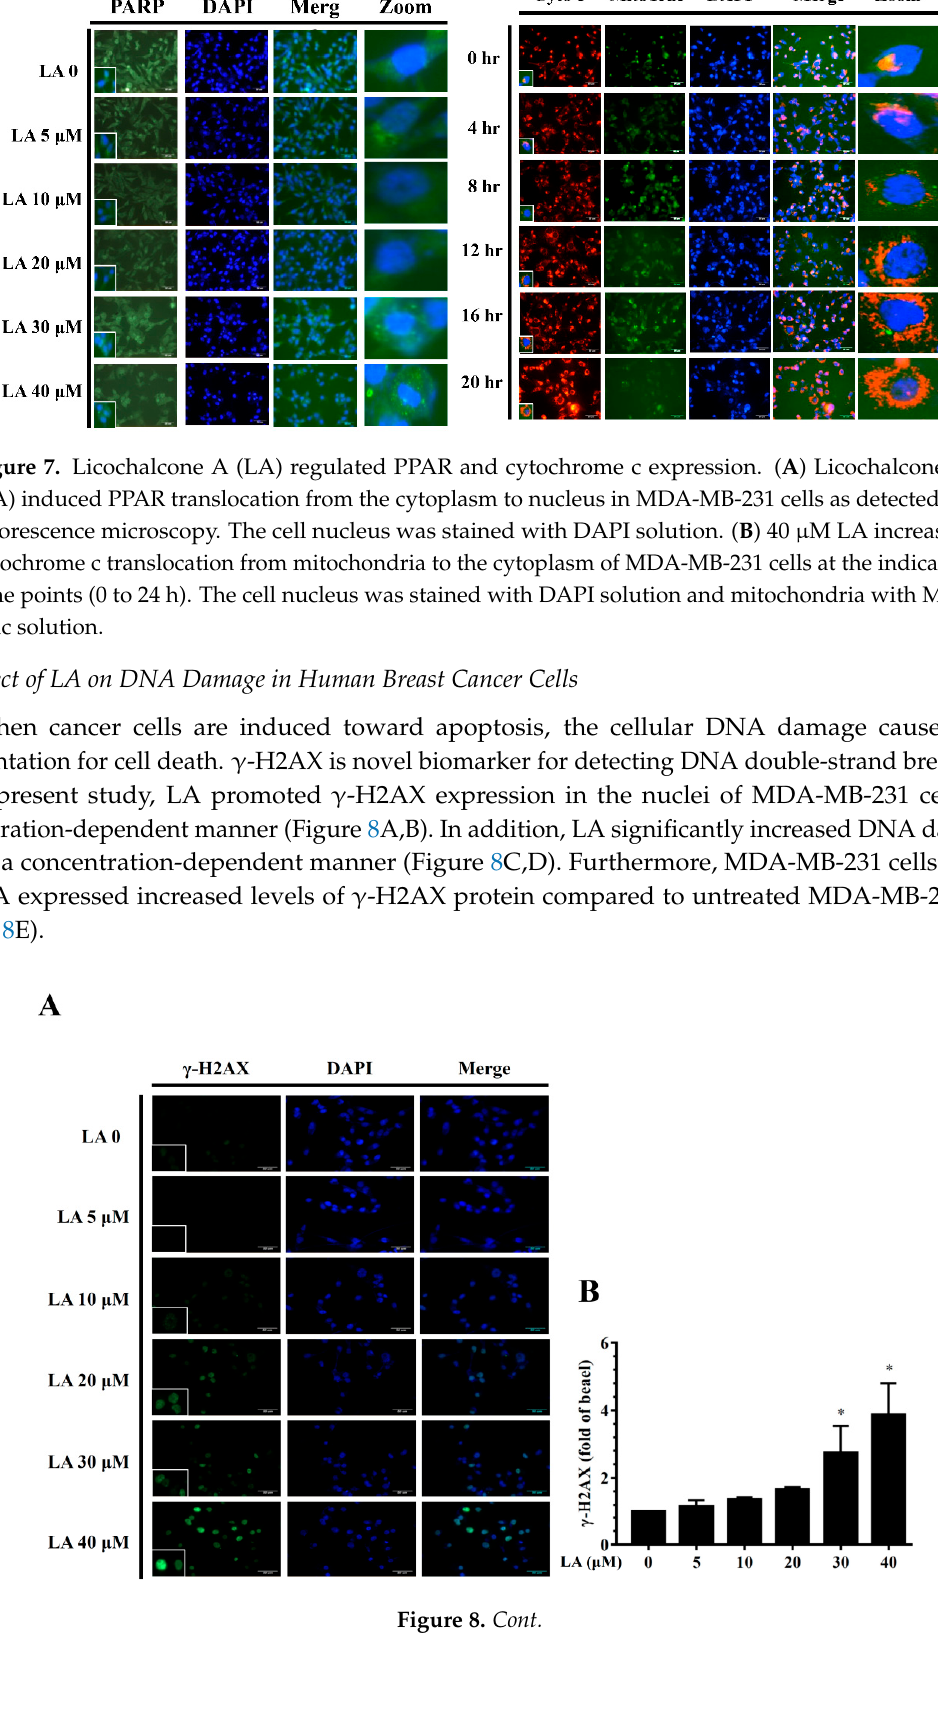
Figure 8. Effect of licochalcone A (LA) on DNA damage in MDA-MB-231 cells. ( A ) Cells were seeded on a culture plate and treated with LA, incubated with γ -H2AX antibodies, and detected by fluorescence microscopy. The cell nucleus was stained with DAPI solution. ( B ) The fold expression of γ -H2AX relative to cells not treated with LA. ( C ) DNA damage assay using the Multi-Color DNA Damage Kit, and cellular DNA damage detected by flow cytometry. ( D ) Percentage of DNA damaged cells in each group. ( E ) γ -H2AX protein expression assessed by Western blot, with β -actin as an internal control. The data are presented as mean ± SD of three independent experiments (n = 6). * p < 0.05, ** p < 0.01 compared to untreated cells (0 μ M LA). 3.9. Effect of LA on ROS Production LA treatment dose-dependently promoted ROS levels (Figure 9A). Treating MDA-MB-231 cells with 40 μ M LA for different durations (0–90 min) showed that ROS levels increased in accordance with the duration of treatment (Figure 9B). Fluorescence microscopy showed that LA could increase intracellular ROS production compared to untreated MDA-MB-231 cells (Figure 9C,D). Flow cytometry also confirmed that LA increased intracellular ROS levels compared to untreated